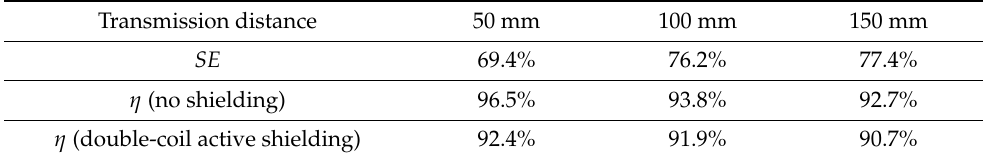
Table 4. SE and η at different transmission distances.